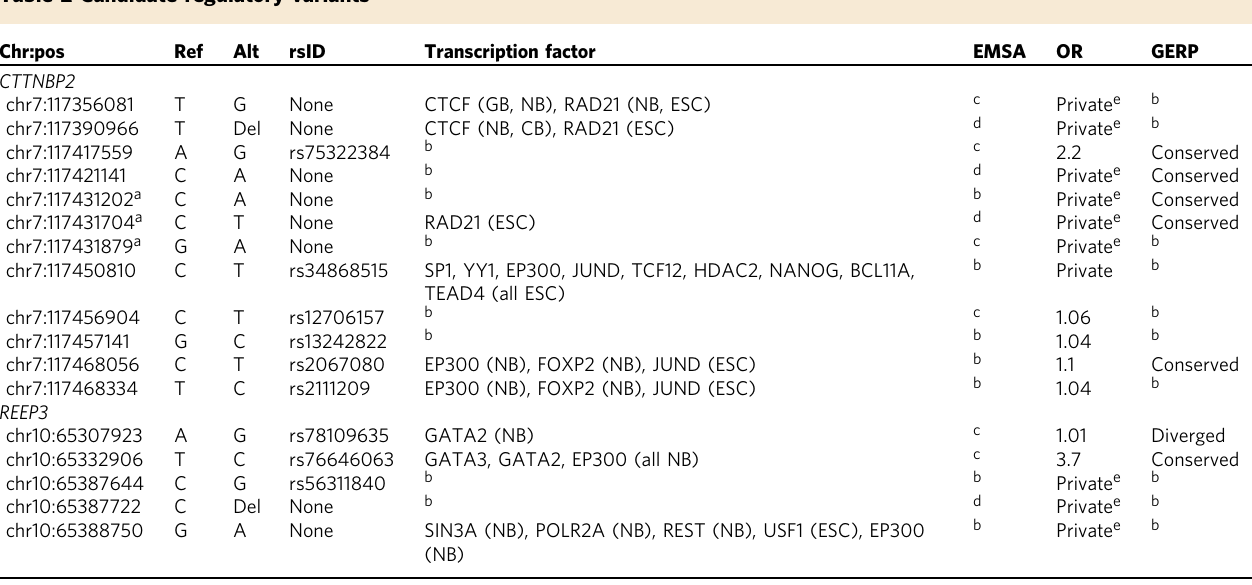
We identi fi ed twelve candidate regulatory SNPs in CTTNBP2 , including: seven intronic SNPs with DHS signals in neural stem cells (SK-N-MC) or neuroblasts (SK-N-SH, BE2-C, SH-SY5Y, SK-N-SH-RA), fourofwhichalsooverlapTF-bindingsitesinthebrain-derivedcelllines;twointronicSNPsnearthetopDHSvariantsandpotentiallyalteringthesameregulatoryelements;andthreecodingSNPsthatlie within or near regulatory marks (Supplementary Fig. 7b). We also identi fi ed fi ve candidate regulatory SNPs in or near REEP3 , including: one intronic SNP (chr10:65307923) in a DHS and GATA2 TFBS active in neuroblasts; one intronic SNP (chr10:65332906) that alters a DHS active in neural stem cells and GATA2, GATA3, and EP300 binding sites active in neuroblasts; three noncoding SNPs (chr10:65387644, chr10:65387722, and chr10:65388750) that cluster ~3kb upstream in a DHS active in multiple brain-related cells, including neuroblasts, and are seen only in OCD patients in our pooled sequencing (Supplementary Fig. 7c). a Coding; EMSA, electrophoretic mobility shift assay b No change c Strong TF-DNA binding change d Weakchange;GB, glioblast;NB,neuroblast;ESC,embryonicstemcell;CB,cerebellum; “ Transcriptionfactor ” columnshows theTFbindingstotheregions andbrain/developmentalcelltypeswherethe signals are found. OR (odds ratio) column reports data in the combined set, unless noted with e Indicating data from